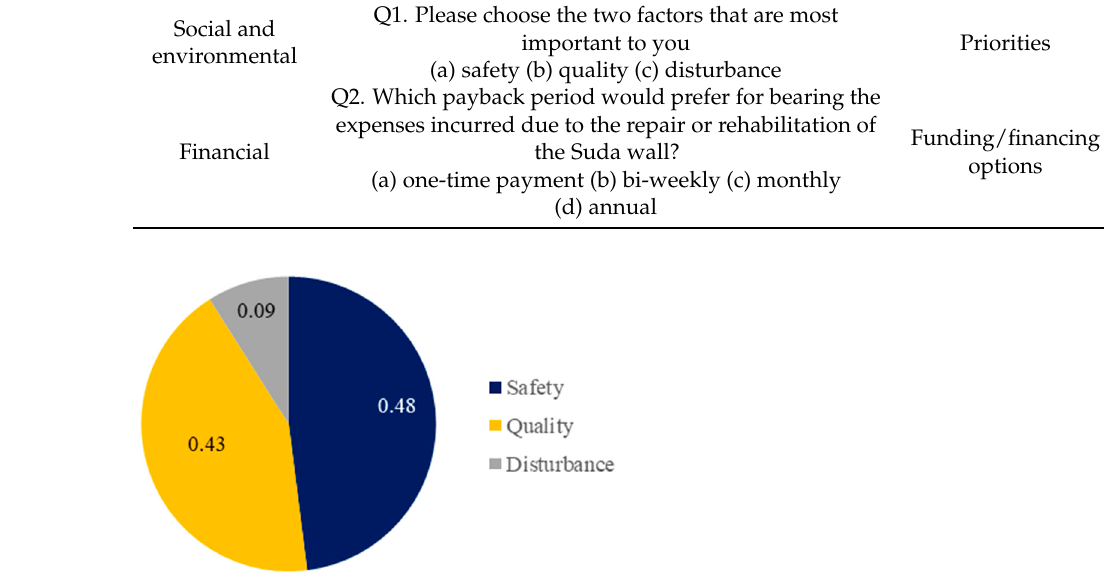
Figure 5. Priorities of the respondents.